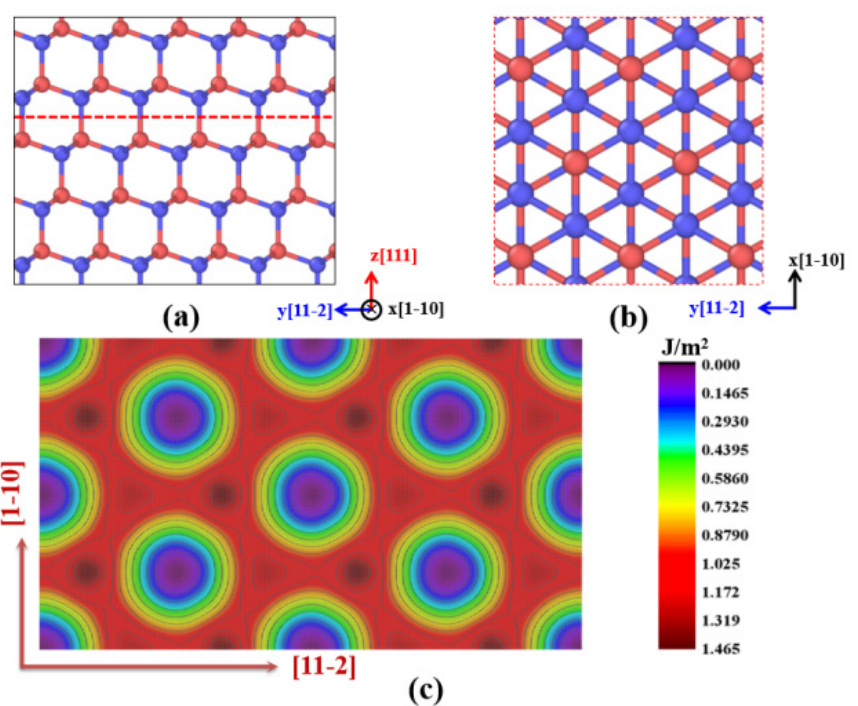
Figure 2. The constructed ZnSe nano film model and the results of the calculated generalized stacking fault energy: ( a ) Front view of the atomic arrangement of the model; ( b ) the atomic arrangement of the model; ( c ) generalized stacking fault energy surface of (111) plane.